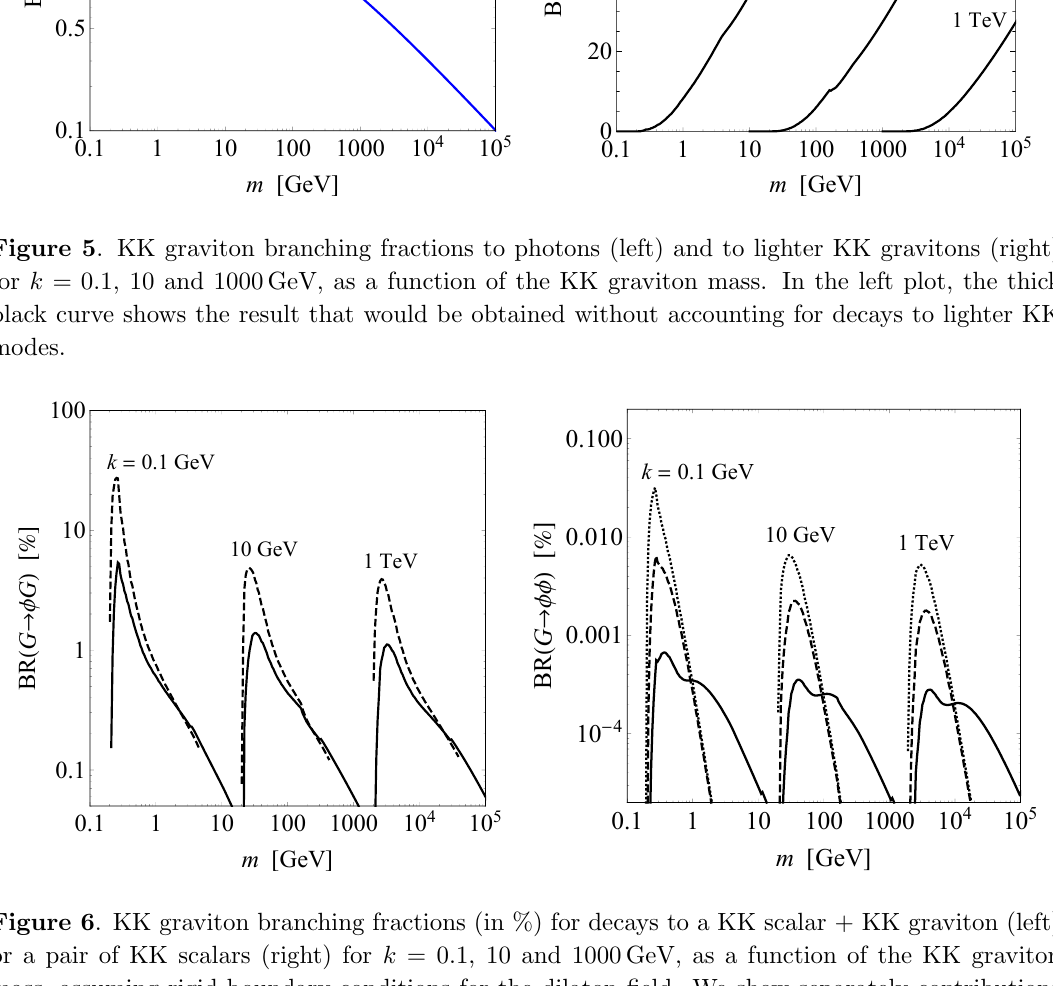
Figure 6 . KK graviton branching fractions (in %) for decays to a KK scalar + KK graviton (left) or a pair of KK scalars (right) for k = 0 : 1, 10 and 1000 GeV, as a function of the KK graviton mass, assuming rigid boundary conditions for the dilaton (cid:12)eld. We show separately contributions involving two scalar zero modes (dotted), one scalar zero mode (dashed) and no zero modes